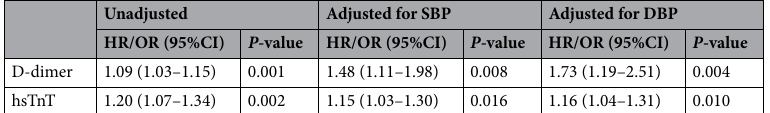
Unadjusted Adjusted for SBP Adjusted for